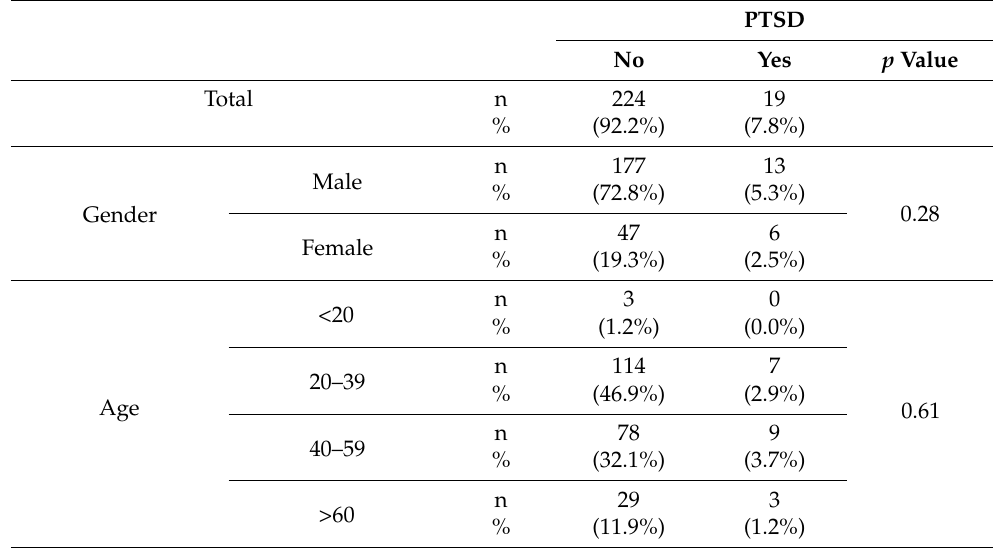
Table 4. Percentage distribution of demographics and post-traumatic stress